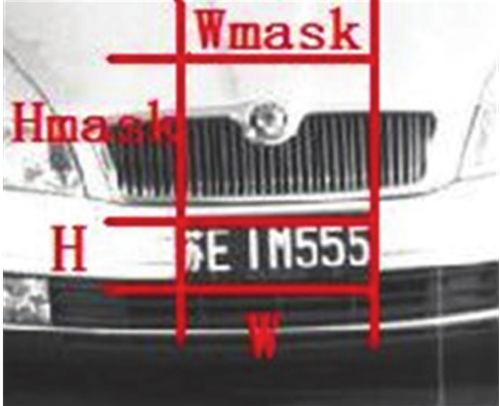
Figure 14: Logo RoI